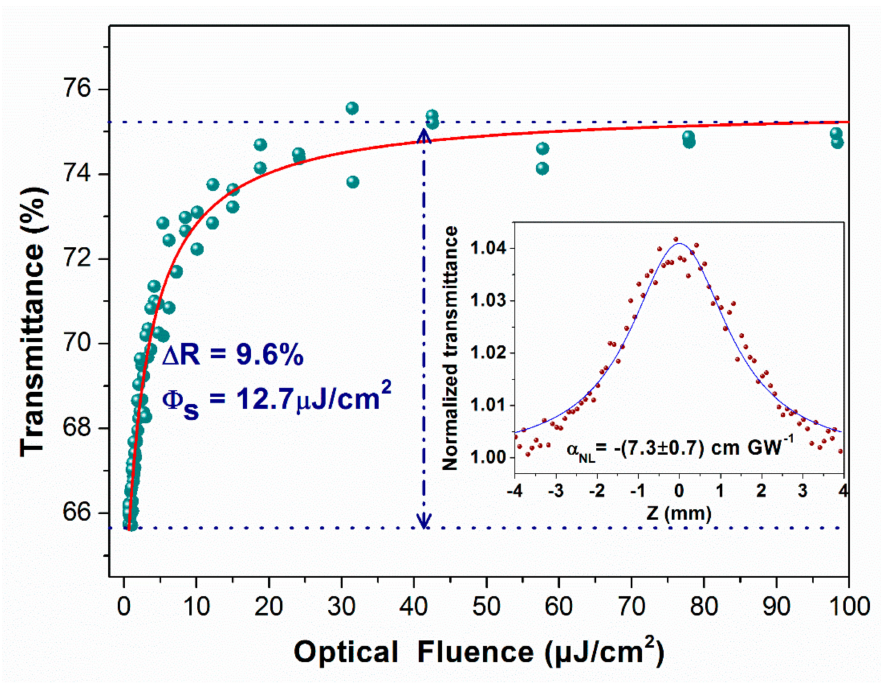
Figure 5. Saturable absorption curve of 2H-TaSe 2 . (Note: The inset shows the open-aperture Z- scan data).